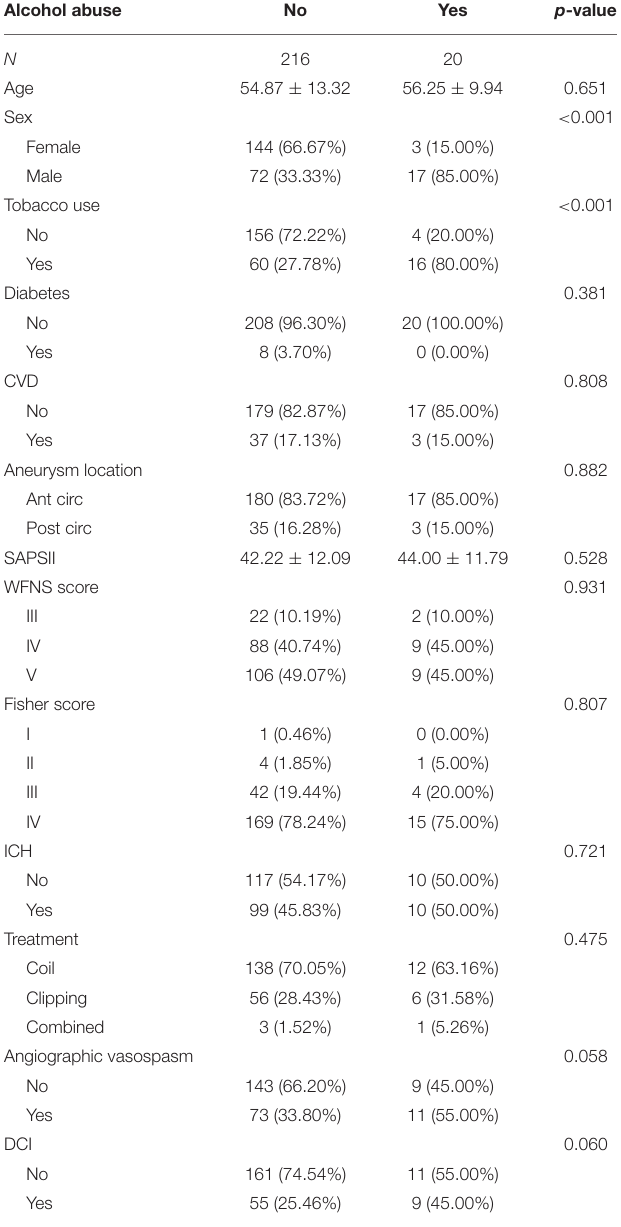
TABLE 1 | Patient demographics and